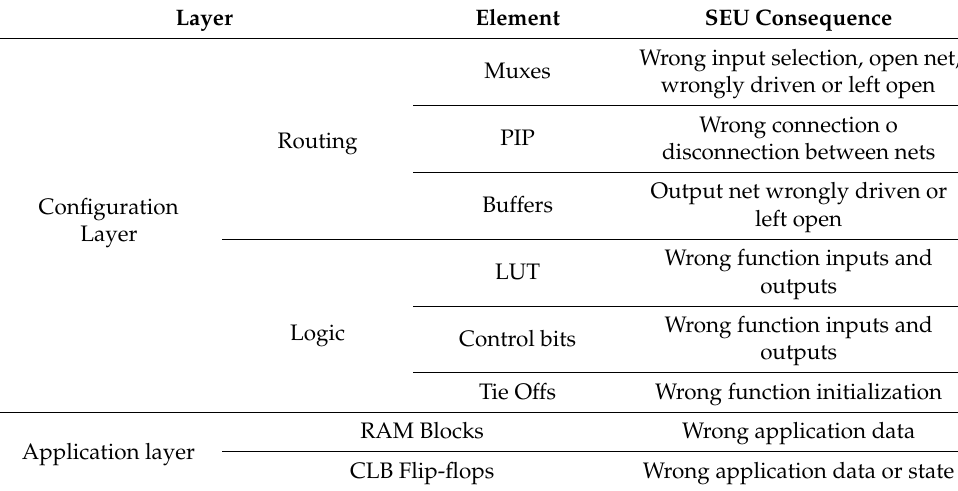
Table 1. Consequences in SRAM-based FPGAs